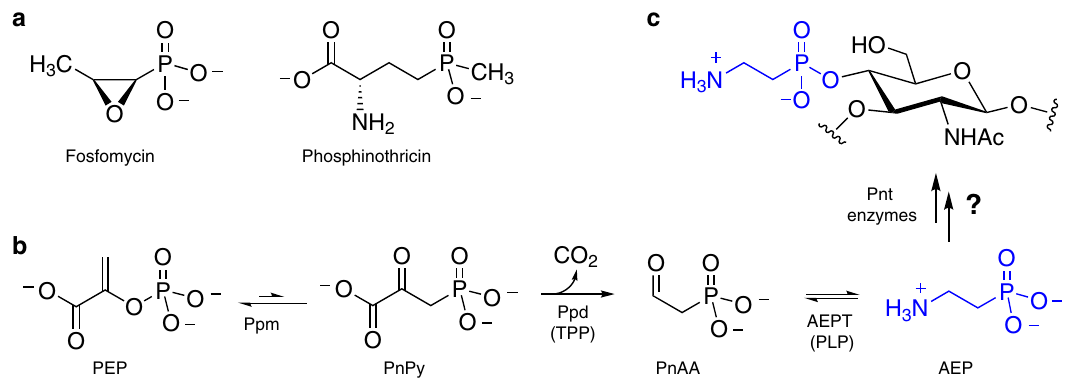
Fig. 1 Phosphonates in nature. a Small molecule bioactive natural products fosfomycin and phosphinothricin. b Biosynthesis of the common phosphonate AEP from phosphoenolpyruvate (PEP) via the intermediacy of phosphonopyruvate (PnPy) and phosphonoacetaldehyde (PnAA). Cofactors in parentheses are thiamine pyrophosphate (TPP) and pyridoxal 5 ′ -phosphate (PLP). Unknown phosphonyl tailoring (Pnt) biosynthetic steps lead from AEP to c , cell surface phosphonoglycans like that isolated from Bacteroides